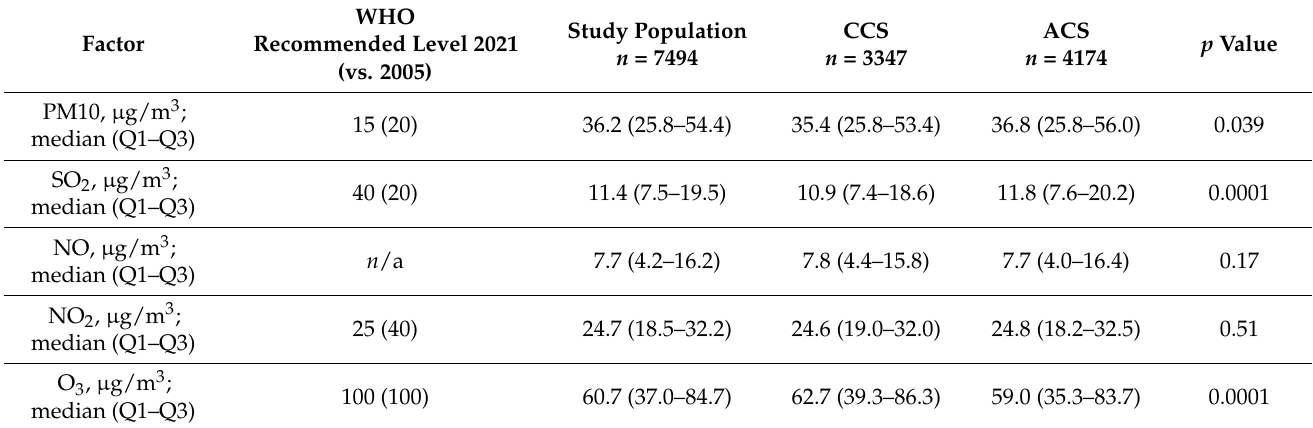
Table 2. Air pollutants during day of admission to the hospital in study